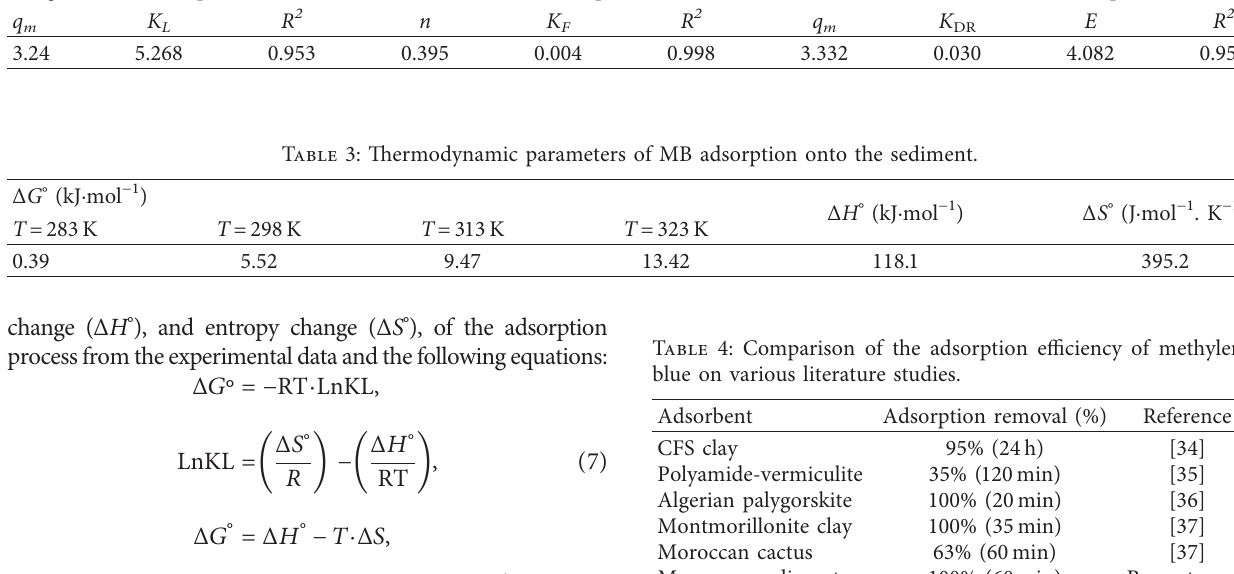
Table 3Values of studied thermodynamic parameters.